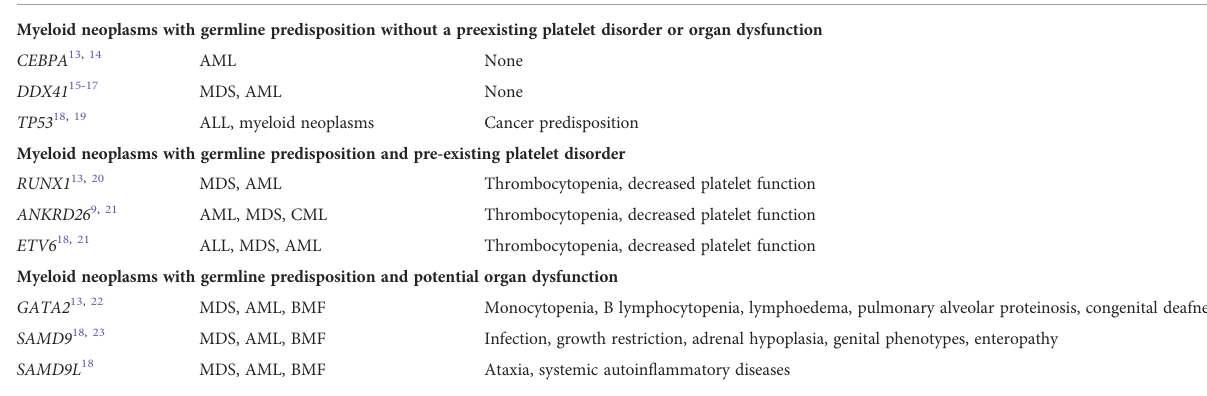
TABLE 1 Major subtypes of myeloid neoplasms associated with germline predisposition 8